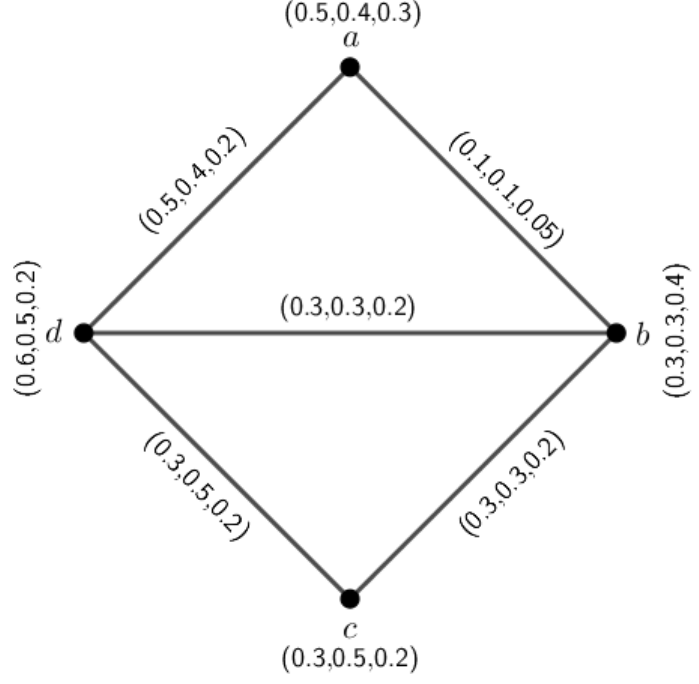
Figure 1. Node integrity of 3PFG Γ